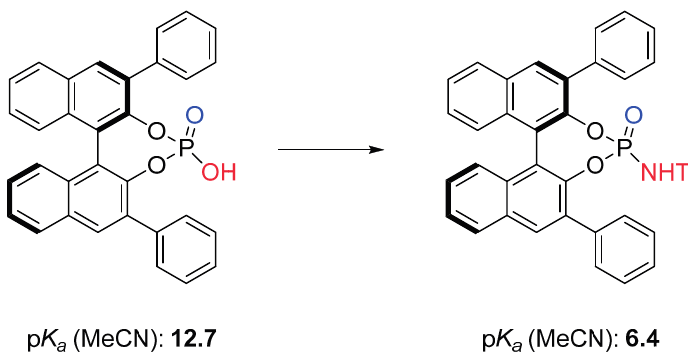
Figure 10. Acidity enhancement of BINOL-derived phosphoric acids via introduction of a NHTf-moiety